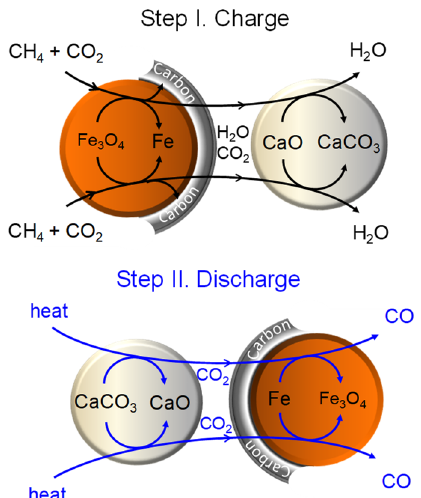
Figure 16. Illustration and working scheme of “combined chemical looping” for energy storage and conversion [84].